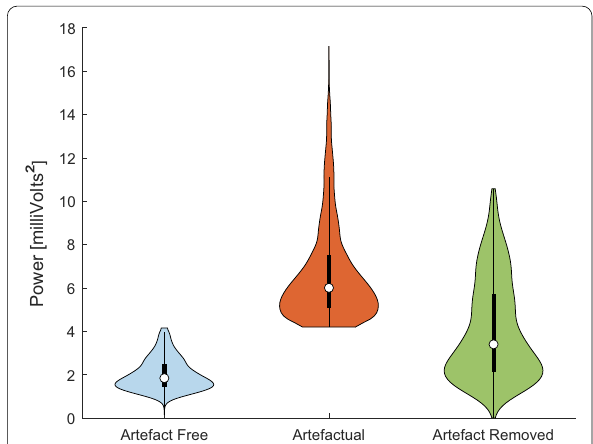
Fig. 10 Violin Plot of power in the normal (blue) 1-s segments, artefactual segments before (red) and after (green) processing from data set 2. The method has reduced the power of the artefactual segments to similar values to the artefact-free